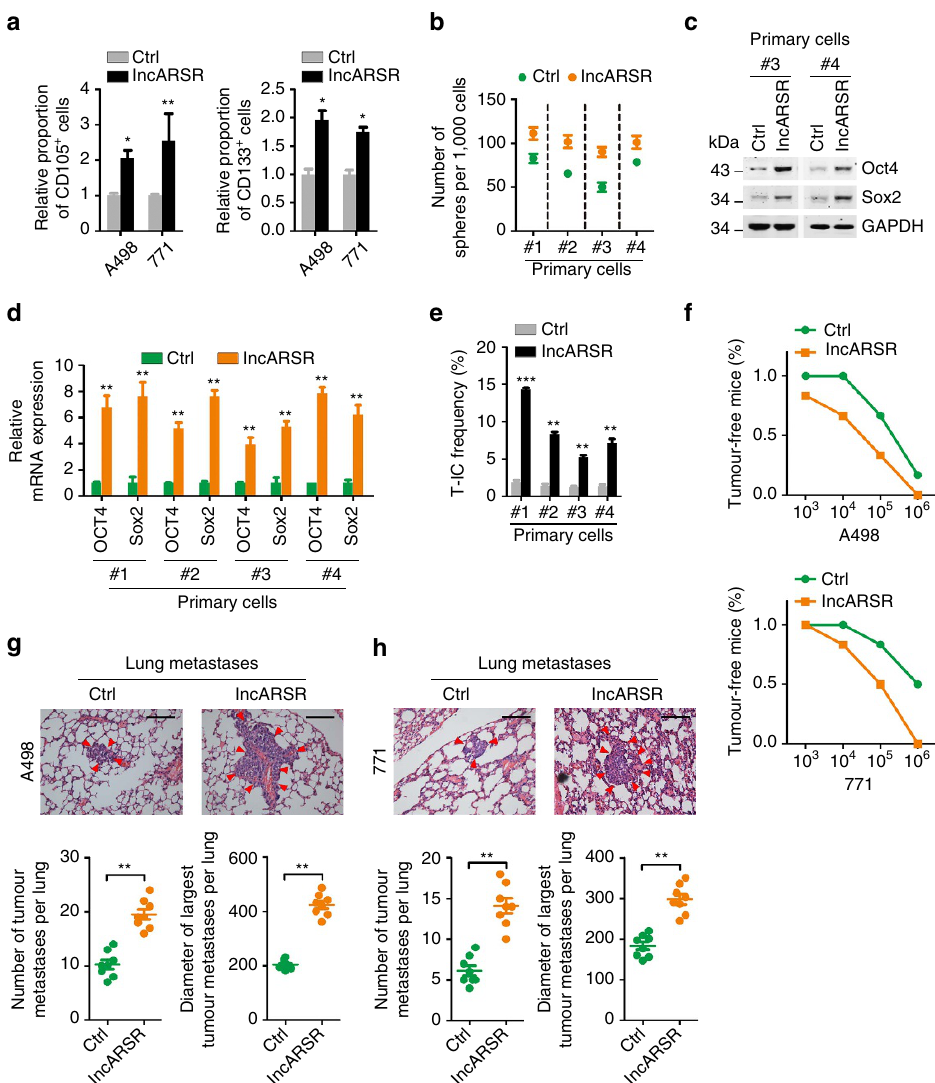
Figure 3 | lncARSR promotes renal T-ICs expansion. ( a ) Flow cytometric analysis of the proportion of CD105 þ (left) or CD133 þ (right) cells in lncARSR- overexpressing and control RCC cells ( n ¼ 3). Data are represented as mean ± s.d.; * P o 0.05 and ** P o 0.01; two-tailed Student’s t -test. ( b ) Spheres formation assay of lncARSR-overexpressing and control primary ccRCC cells ( n ¼ 3). The number of spheres was counted after 7 days. ( c ) Western blot analysis of Oct4 and Sox2 in lncARSR-overexpressing and control primary ccRCC cells. ( d ) qRT–PCR analysis of indicated mRNAs in lncARSR- overexpressing and control primary ccRCC cells. Data are represented as mean ± s.d.; ** P o 0.01; two-tailed Student’s t -test. ( e ) In vitro limiting dilution assay of lncARSR-overexpressing and control primary ccRCC cells. The results were shown as natural logarithm of the proportion of T-ICs. ( f ) In vivo limiting dilution assay of lncARSR-overexpressing and control RCC cells. Tumours were observed over 2 months; n ¼ 6 for each group. ( g , h ) Representative microscopic images of pulmonary metastatic lesions at 12 weeks after the injection of indicated RCC cells into the tail vein of nude mice (upper). Red arrows indicate lung metastatic tumours (left). Scale bar, 200 m m. The number (lower left) and diameter (lower right) of lung metastatic tumours in each group ( n ¼ 8) were calculated. Data are represented as mean ± s.d.; ** P o 0.01; two-tailed Student’s t